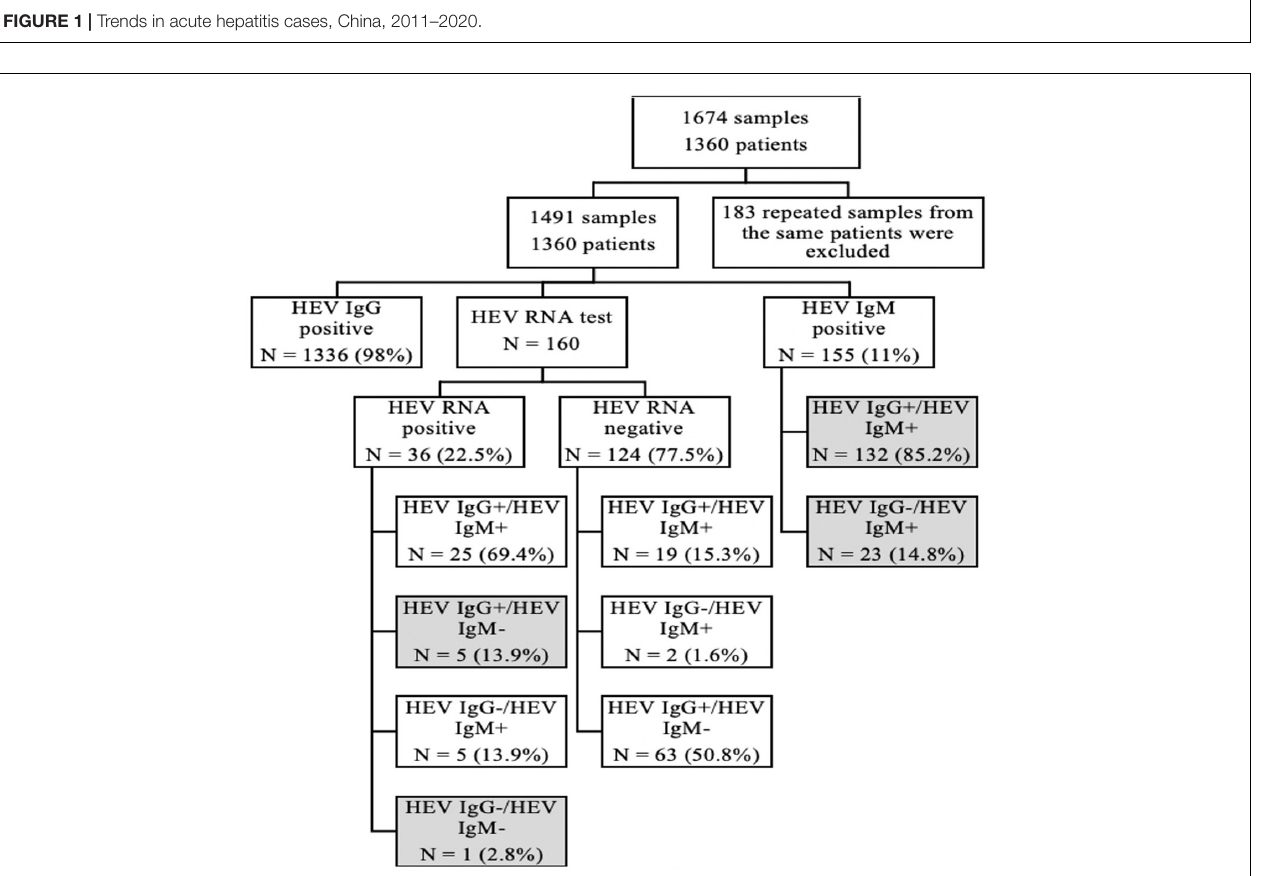
FIGURE 2 | Our patient cohort was stratified according to HEV serology and PCR